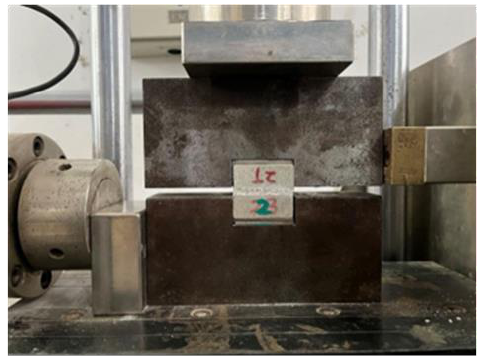
Figure 10. Fault rocks placed in the RJST-616 direct shear